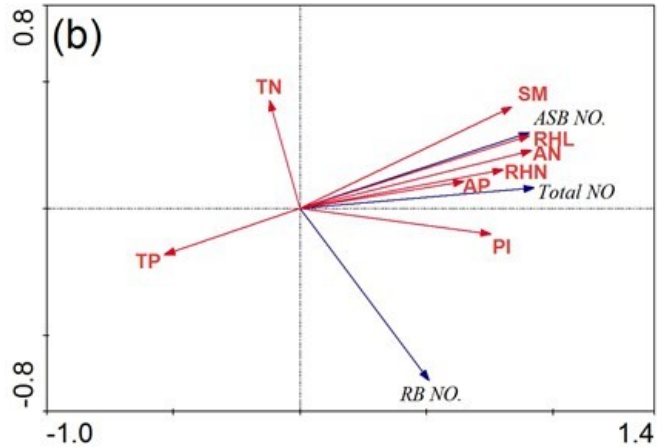
Figure 6. The redundancy analysis of the relationship of soil environment and plant traits to bud bank density in spring ( a ) and autumn ( b ). The axis represents a linear combination of the environment variables that participated in the sort. Each trait is represented by the mean of sample means in all samples. The red arrows represent environmental variables, and the blue arrows represent species variables. Total, total bud number; ASB, axillary shoot bud number; RB, rhizome bud number; TN, total nitrogen; TP, total phosphorus; AN, available nitrogen; AP, available phosphorus; SM, soil moisture content; RHN, rhizome number; RHL, rhizome length; PI, population density increase.